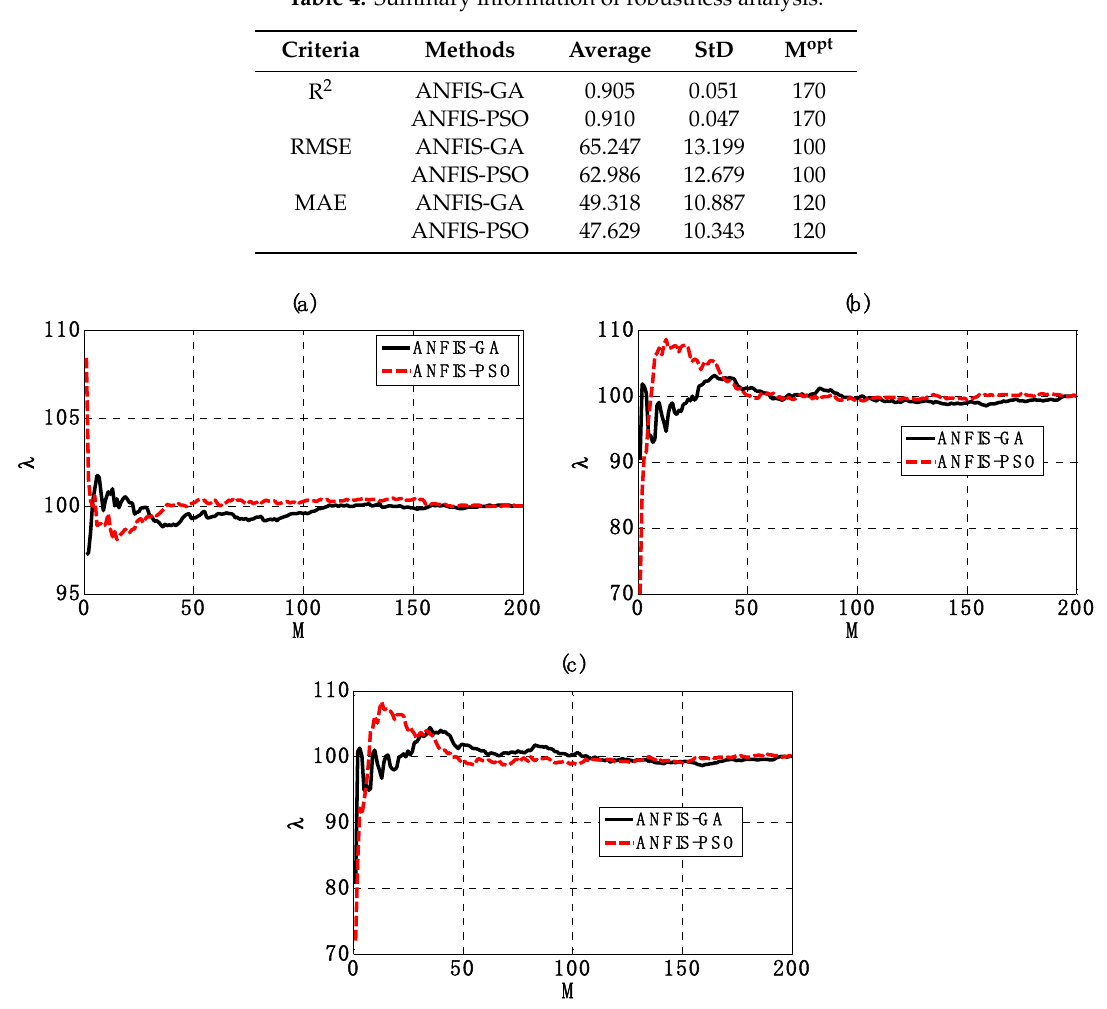
Figure 9. Graphs of the convergence indicator λ over 200 Monte Carlo realizations for ( a ) R 2 , ( b ) Root Mean Squared Error (RMSE) and ( c ) Mean Absolute Error (MAE).